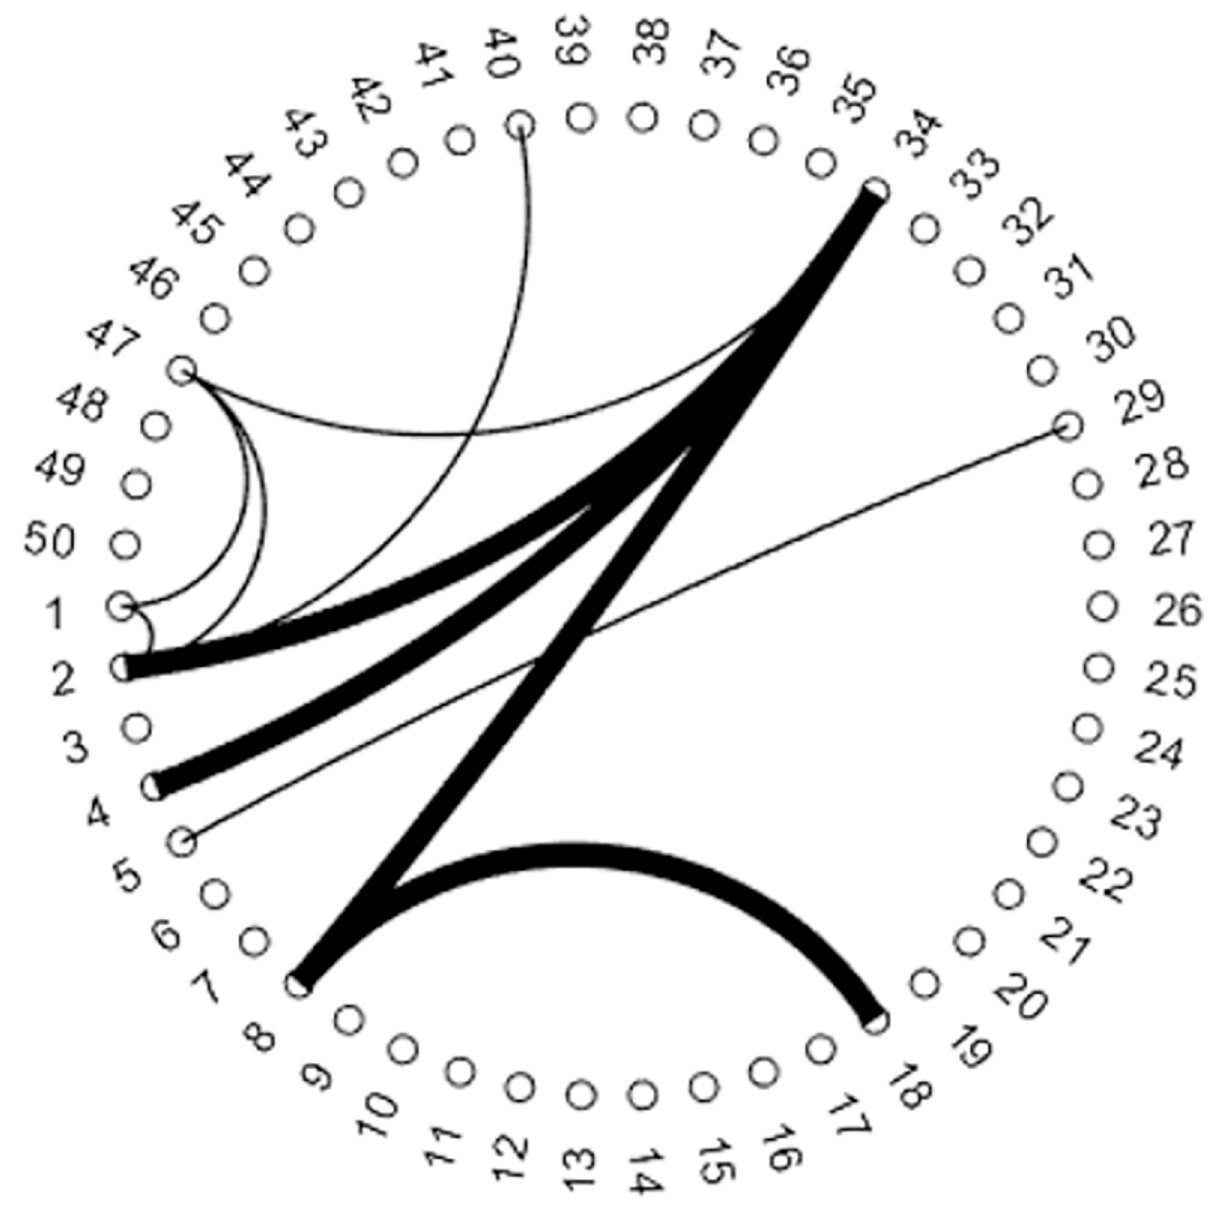
Fig 5. Difference in the dynamic functional connectivity between the first 10 and last 10 second of the app stimulus. Thin lines indicate connectivity only for the beginning of the stimulus while thick lines indicate connectivity only for the end of the stimulus. Functional connectivity between other pairs of regions is same as shown in Fig 4. (This figure is to be inferred along with Fig